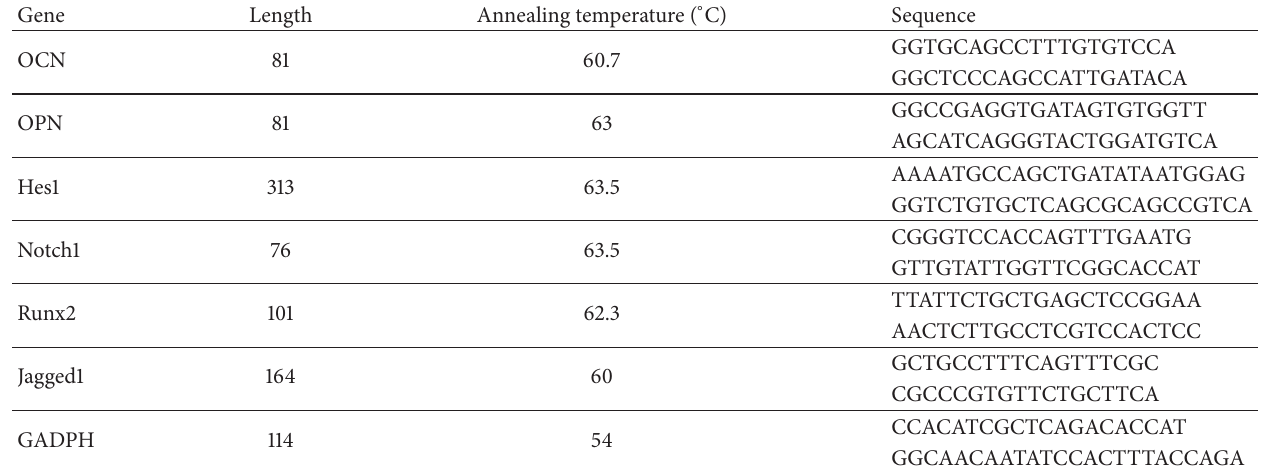
Table 2: Primers sequences for real-time RT-PCR